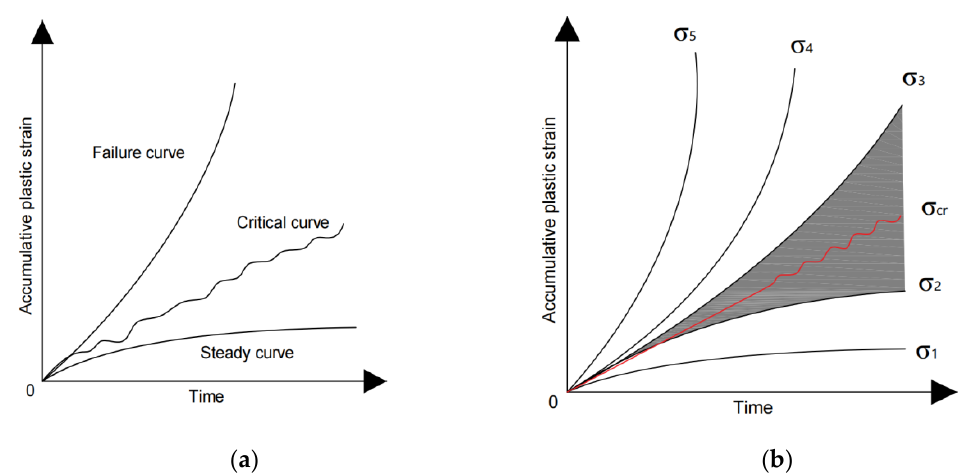
Figure 4. ( a ) Representative accumulative strain-time curve; ( b ) Analysis of critical dynamic stress.